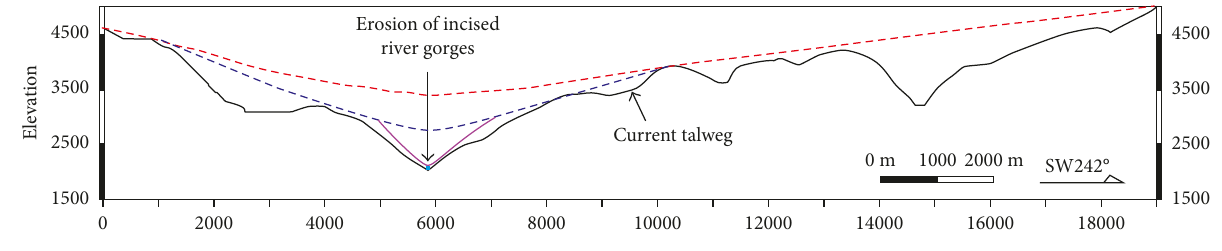
Figure 2: Typical terrain profile of the river